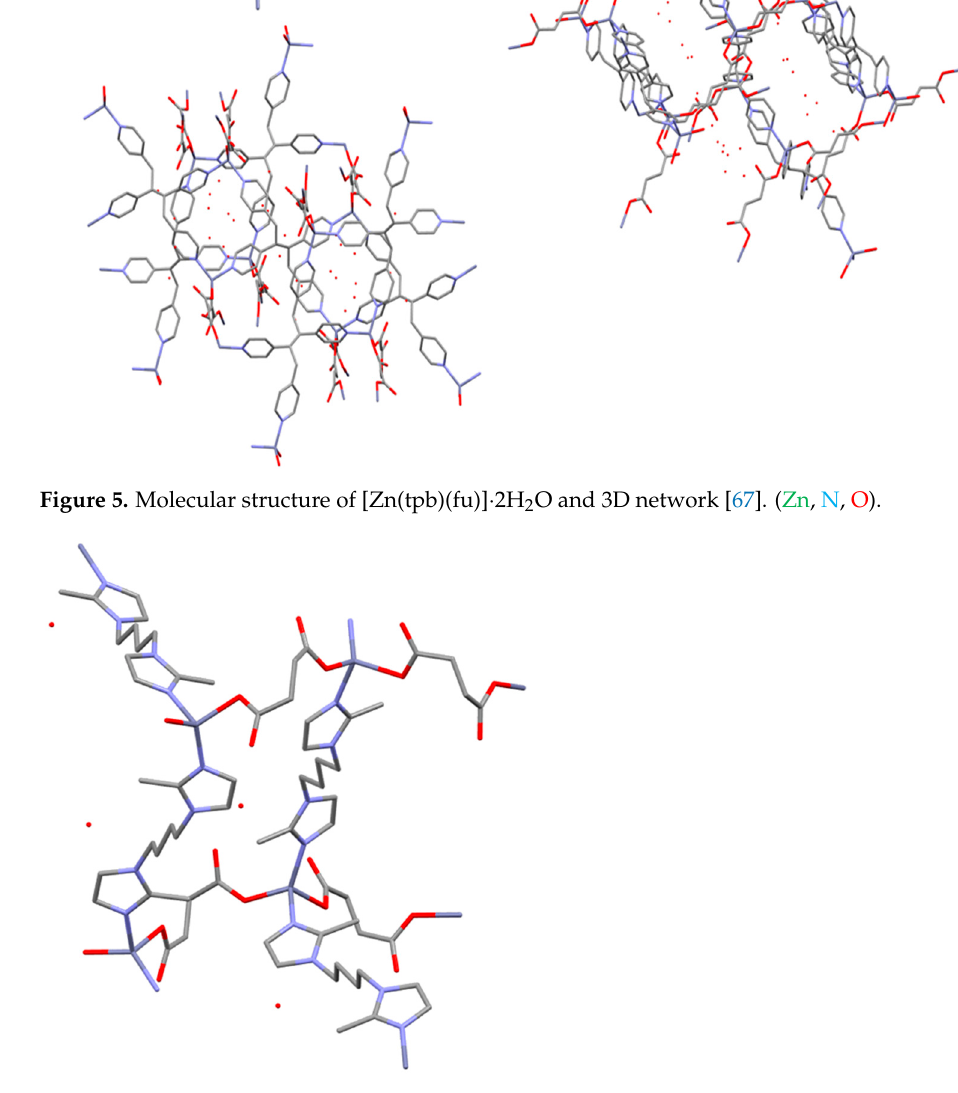
Table 8. Ni(II) complexes with 2,2 ′ -thiodiacetic acid and N donor ligands that are structurally char- acterized.